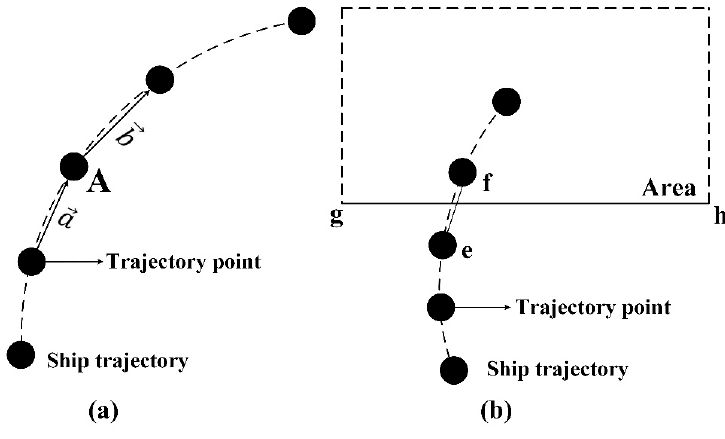
Figure 3. Turning and i / o state’s Figure 3. turning and i / o state’s recognition.